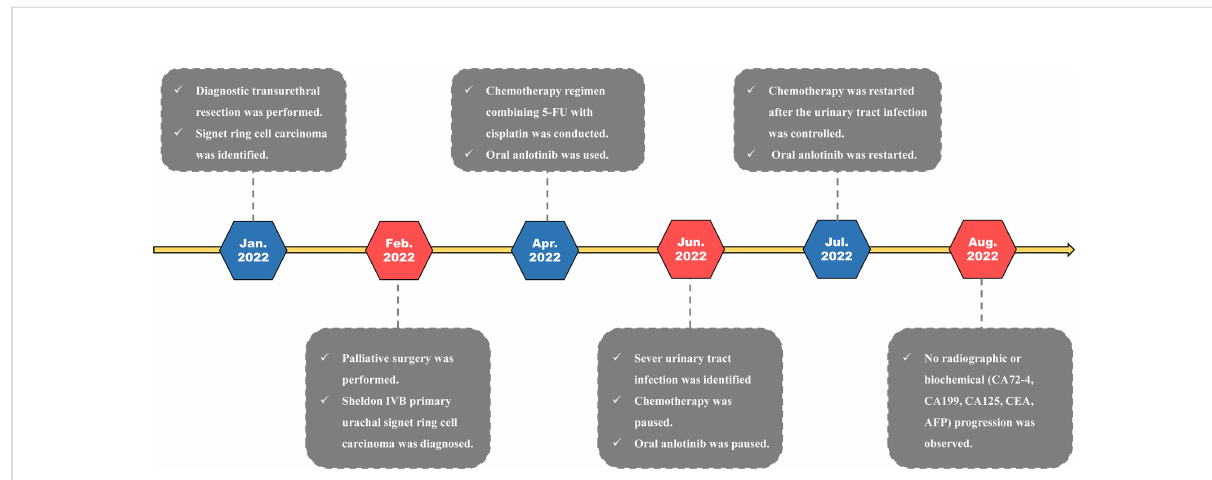
FIGURE 3 Treatment timeline of the current urachal signet ring cell carcinoma case.